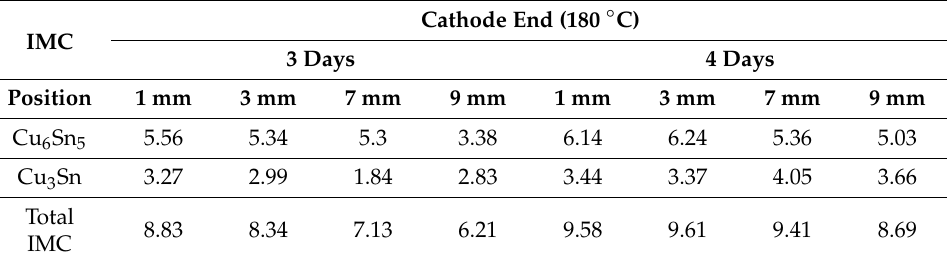
Figure 13. SEM images of various samples heated at 180 °C and subjected to a current of 0.8 A after 4 days. ( a ) Anode ends (indicated on red circle) on the 1mm side of 1:9 sample; ( b ) Anode ends (indicated on red circle) on the 3mm side of 3:7 sample; ( c ) Anode ends (indicated on red circle) on the 7mm side of 3:7 sample; ( d ) Anode ends (indicated on red circle) on the 9mm side of 1:9 sample. Table 8. The IMC formation and their corresponding thickness in the cathode end of the sample heated at 180 ◦ C and subjected to a current of 0.8